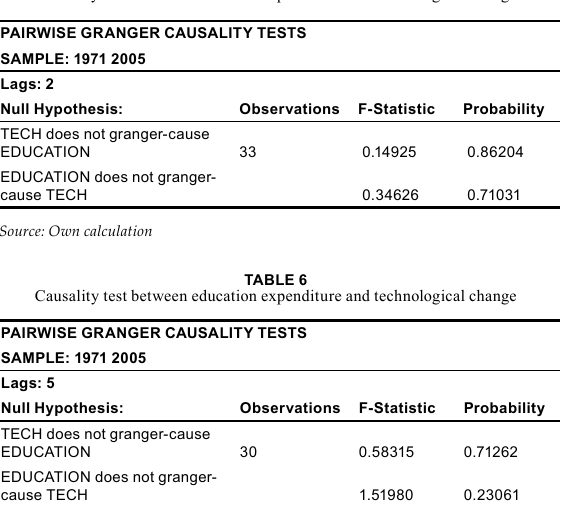
table 5 Causality test between education expenditure and technological change